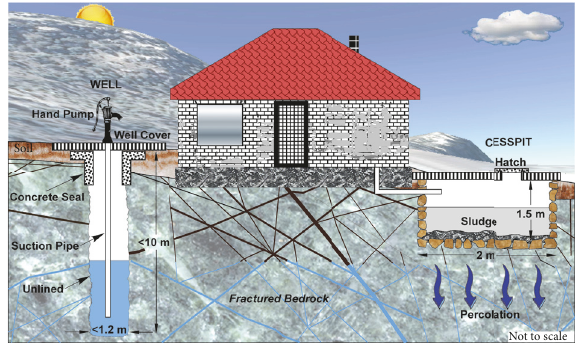
Figure 2: Schematic drawing showing typical designs of hand-dug wells and cesspits in the study